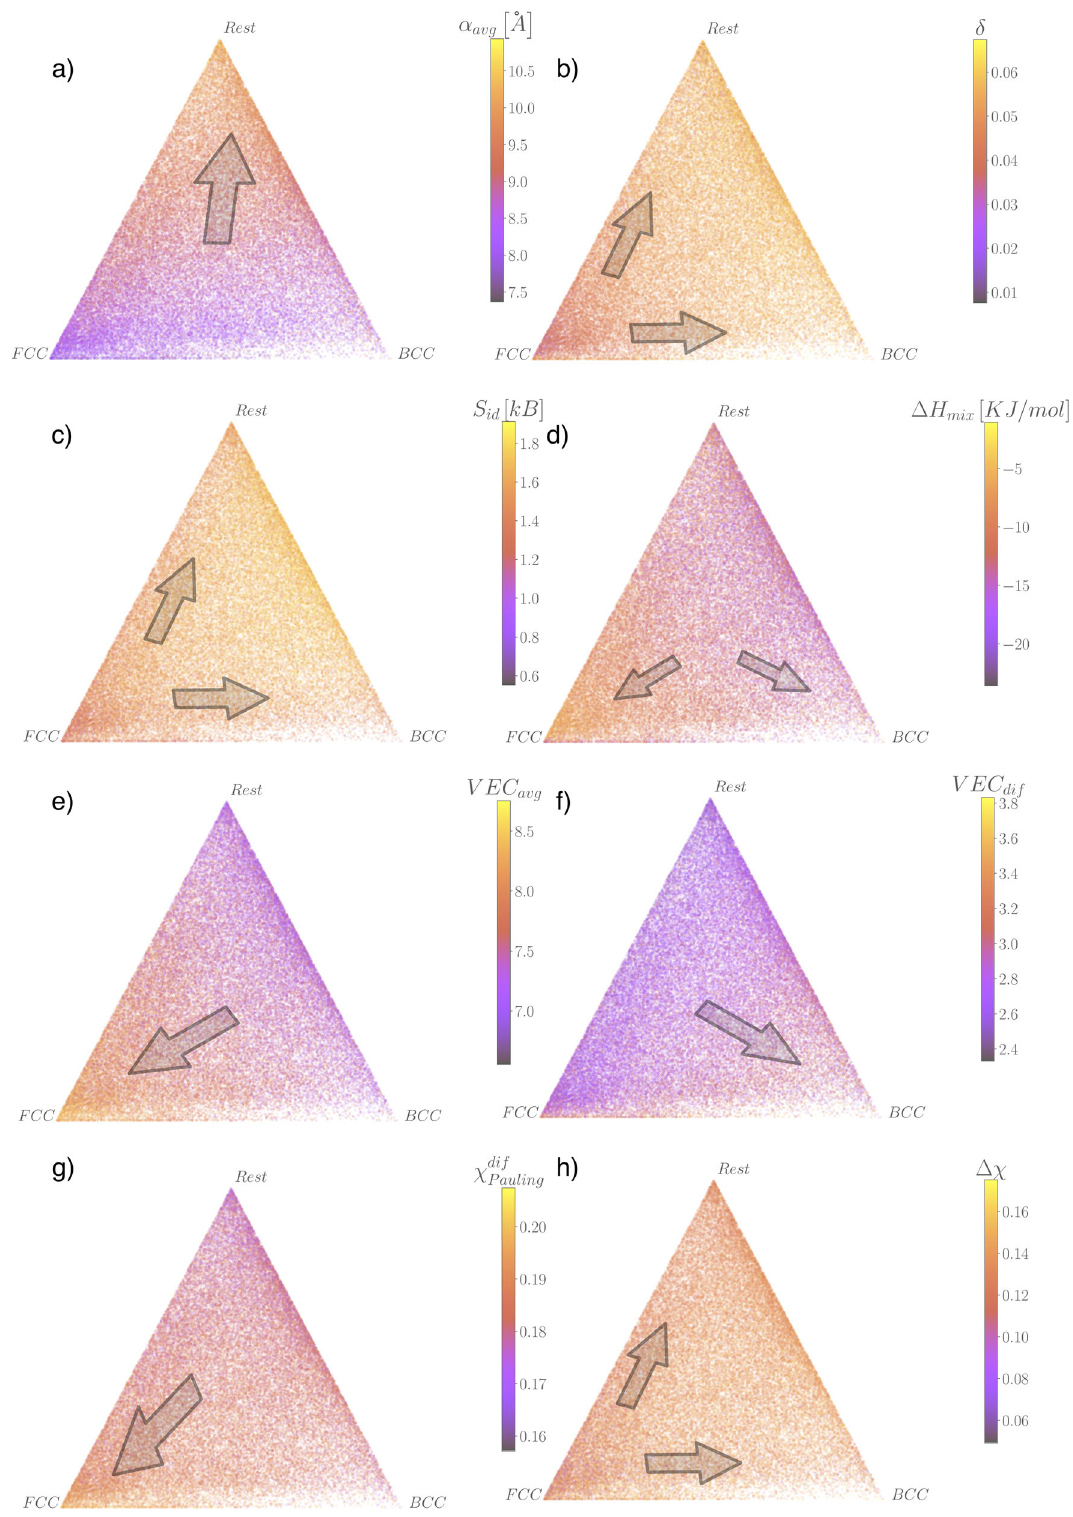
Fig. 6 Phase constitution pseudo-ternary analysis for features of interest. Pseudo-ternary phase fraction plots show a qualitative representation of a random sampling with color heatmap that correspond to the values (Black arrows point towards the higher values in each feature value) for a polarizability average, b the atomic size difference ( δ ), c ideal entropy of mixing, d mixing enthalpy, e the valence electron concentration, f difference mean for the electron concentration, g difference mean for the Pauling electronegativity, and h the standard deviation of electronegativity (not used in